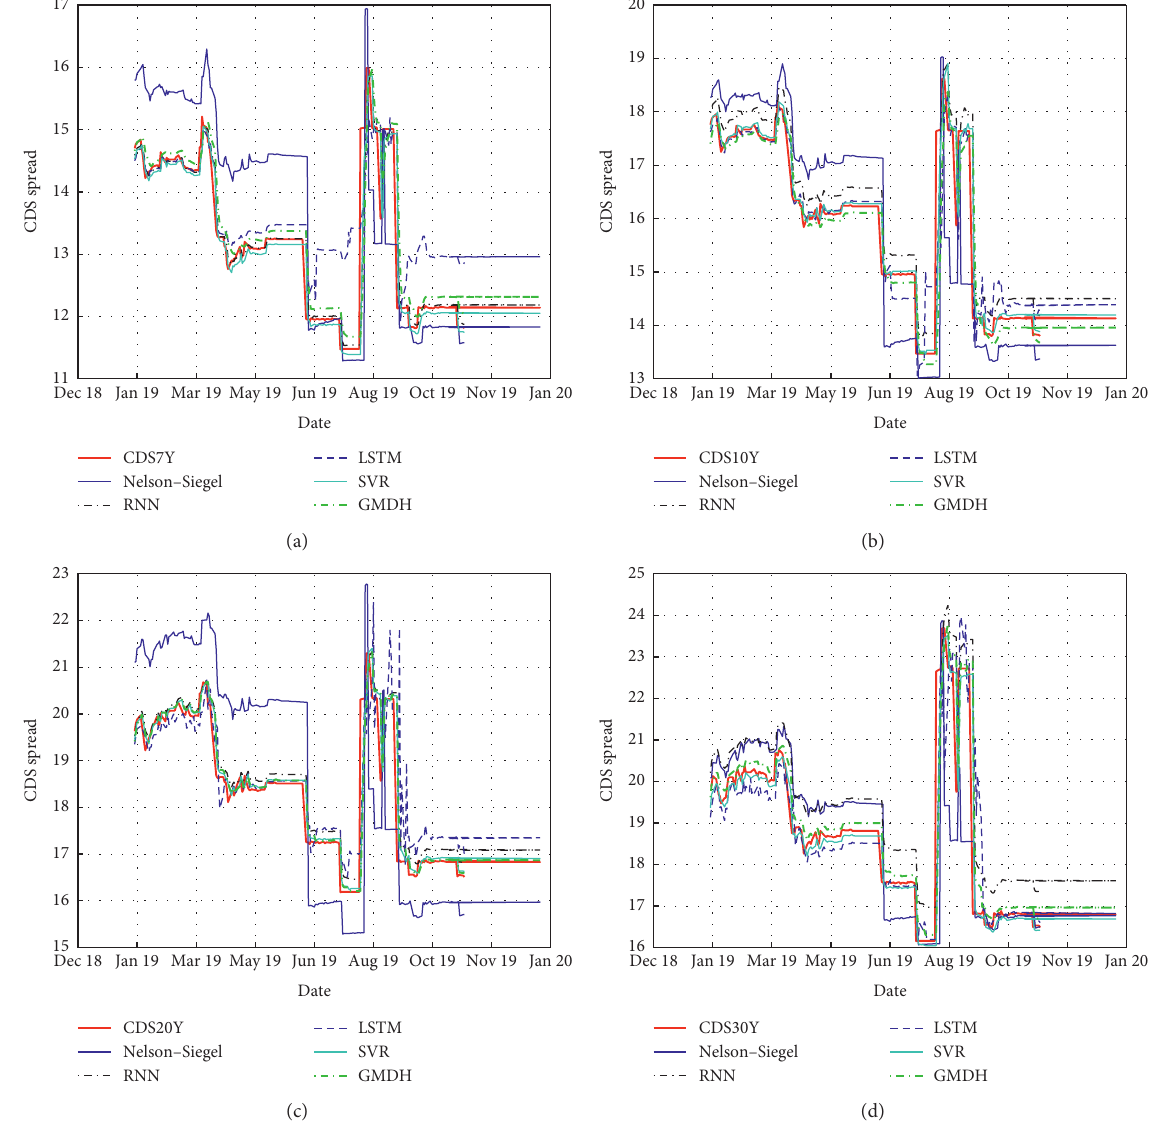
Figure 11: Predictions of each model and target CDS term structure from seven years to 30 years maturity for test dataset 1 with the subperiod 2 training set (case